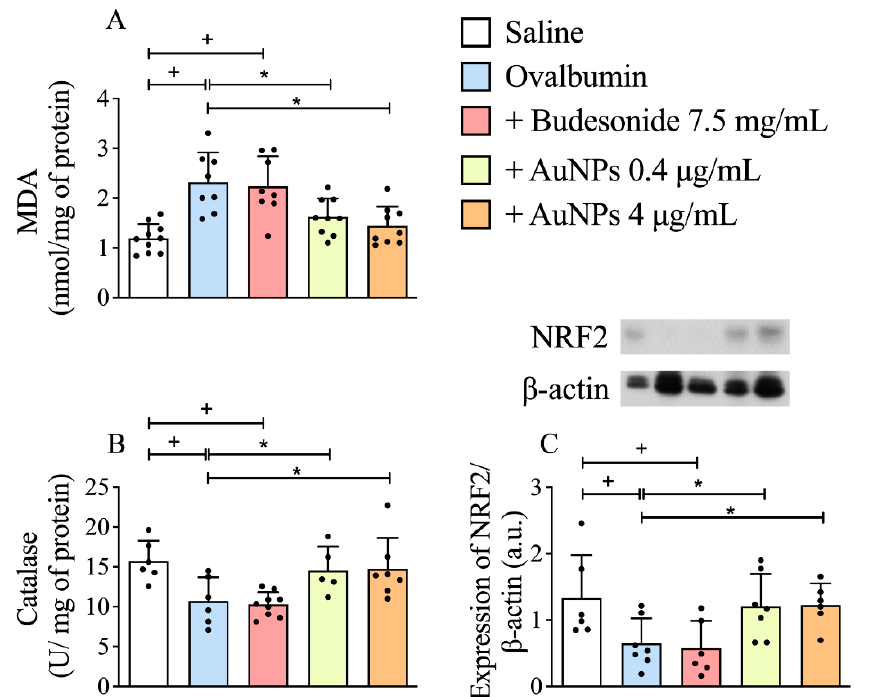
Figure 5. The effect of nebulized Budesonide or gold nanoparticles (AuNPs) on changes in oxidative stress markers following ovalbumin intranasal instillation given once a week for 9 weeks. Biochemical analyses of malondialdehyde (MDA) ( A ) and antioxidant enzyme catalase ( B ), as well as Western blotting evaluation on nuclear factor erythroid 2-related factor 2 (NRF2) expression ( C ), were assessed in whole-lung homogenates. Data are expressed as mean ± SD ((Each dot represents an individual mouse; n = 6–7 for all groups). + p < 0.05 as compared with the saline group, * p < 0.05 as compared with the ovalbumin-challenged group.